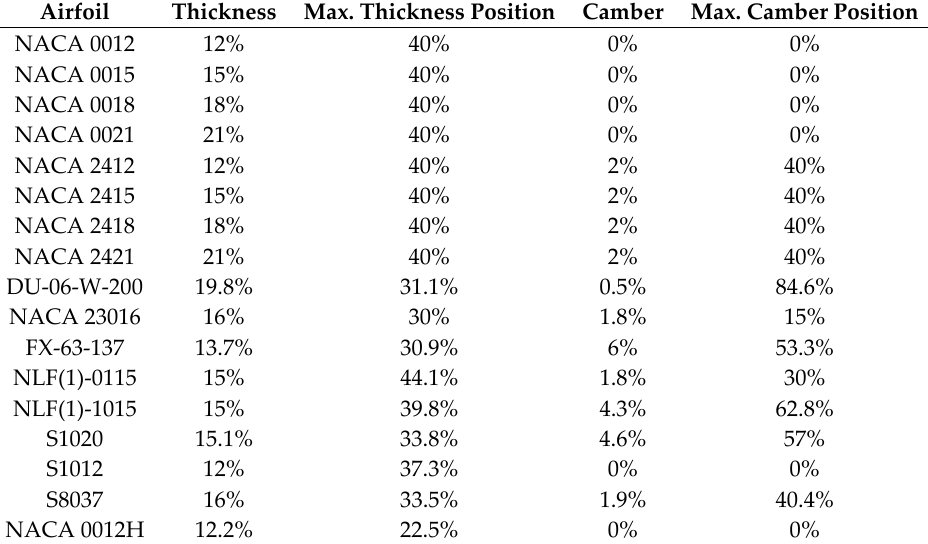
Table 1. Geometrical characteristics of the studied